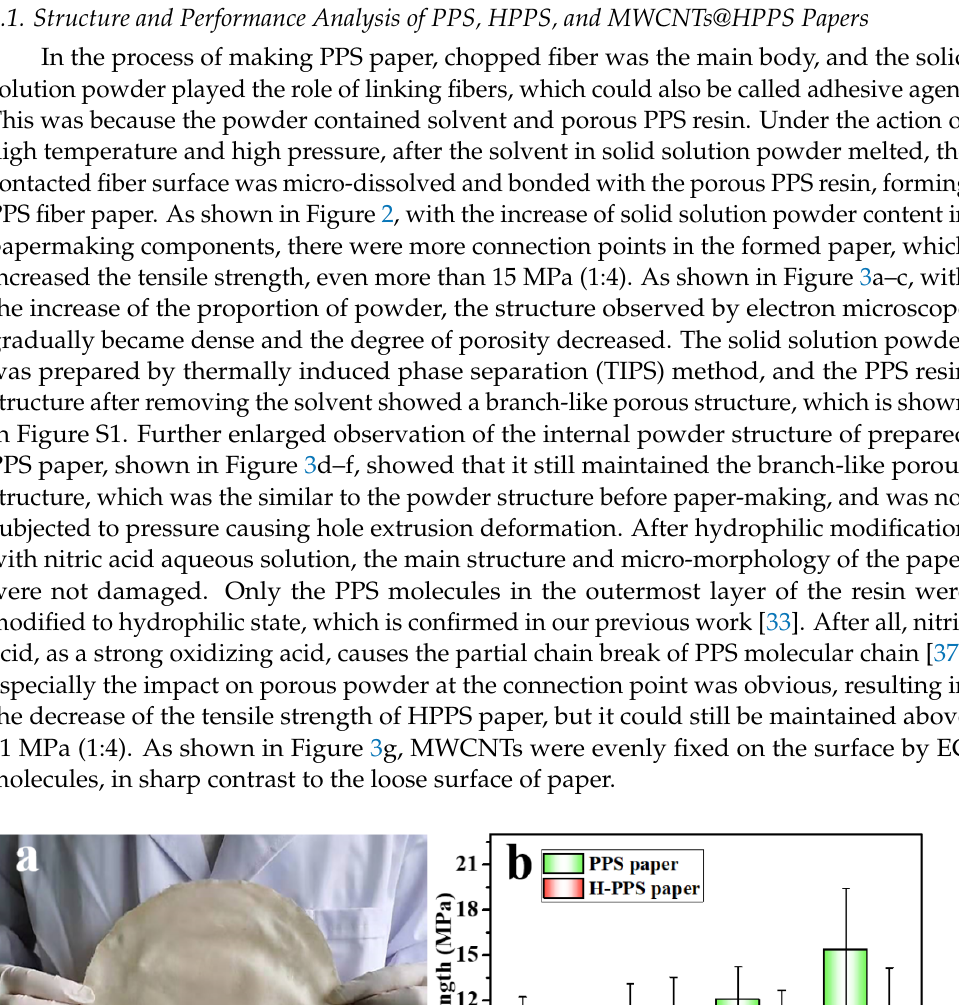
Figure 3. SEM images of PPS papers with weight ratio of PPS chopped fiber and PPS solid solution powder at ( a ) 1:2, ( b , d , e , f ) 1:3, ( c ) 1:4 and ( g ) top surface of MWCNTs@HPPS paper. 1 and 2 represent low and high magnification, respectively. The chemical composition of PPS and HPPS papers were displayed by FTIR spec- trum. As shown in Figure 4a, a new peak appeared at 1039.96 cm − 1 belonging to the -SO- bond, which was due to the oxidation of -S- to -SO- by nitric acid [38]. The peaks emerging at 1641 and 738 cm − 1 and became more intensive corresponding to bending vibration of N-H bonds of primary amine. The envelope-like peak at 3200–3700 cm − 1 attributed to pri- mary amines. As shown in Figure 4b, it could be seen from the XPS survey spectra that a small amount of N element (2.69%) appeared obviously, and the O/S ratio increased sig- nificantly (from 0.25 to 0.45), which proved that more oxygen-containing functional